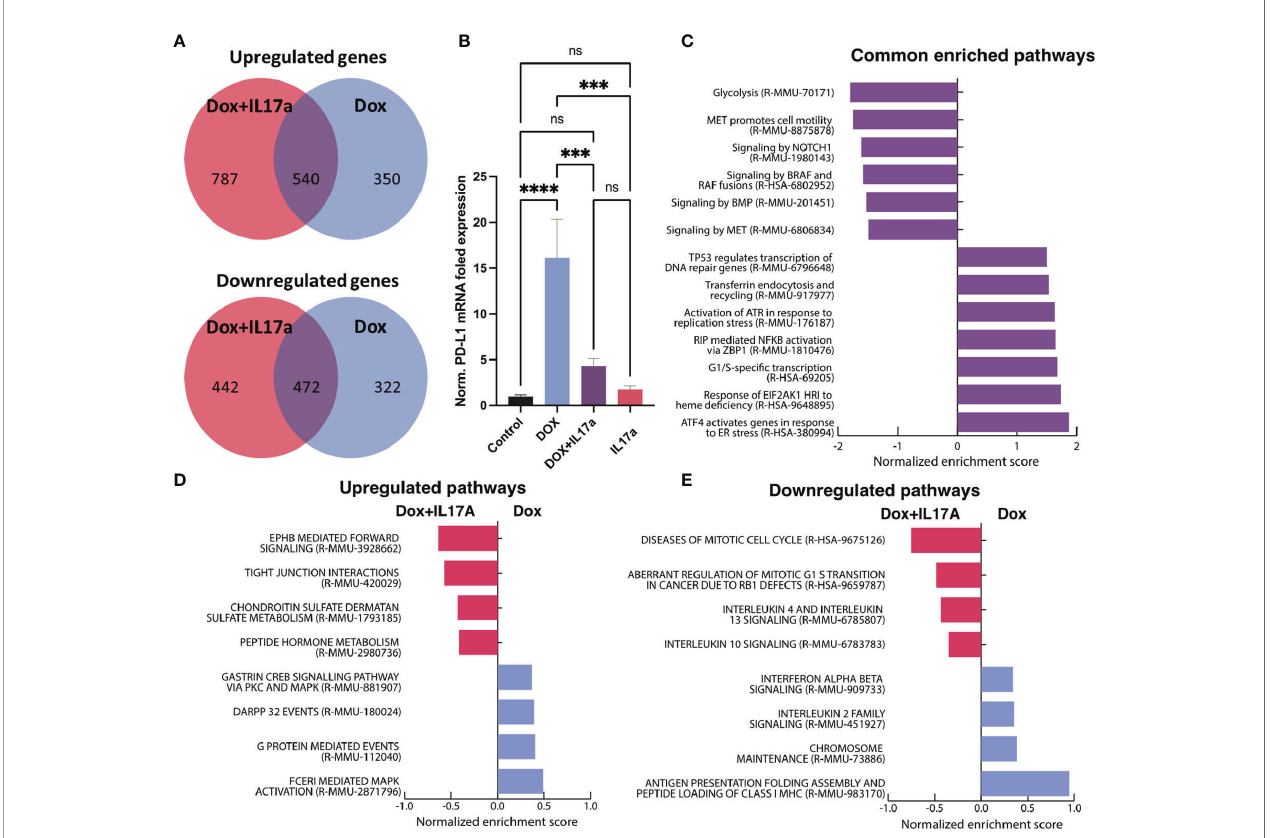
FIGURE 7 | Transcriptomic analysis of 4T1 cells in response to DOX and IL-17A. (A) Venn diagrams depicting overlapping differentially expressed genes from 4T1 cells exposed to DOX +/- IL-17A for 48 hours. (B) Normalized gene expression of CD274 (PD-L1) across in vitro conditions. (C) GSEA analysis of enriched Reactome pathways in common to DOX treated cells regardless of IL-17A. (D) Upregulated pathways with differential enrichment. (E) Downregulated pathways with differential enrichment (n=3-4). ns non-signi fi cant p > 0.05; *** p ≤ 0.001; **** p ≤